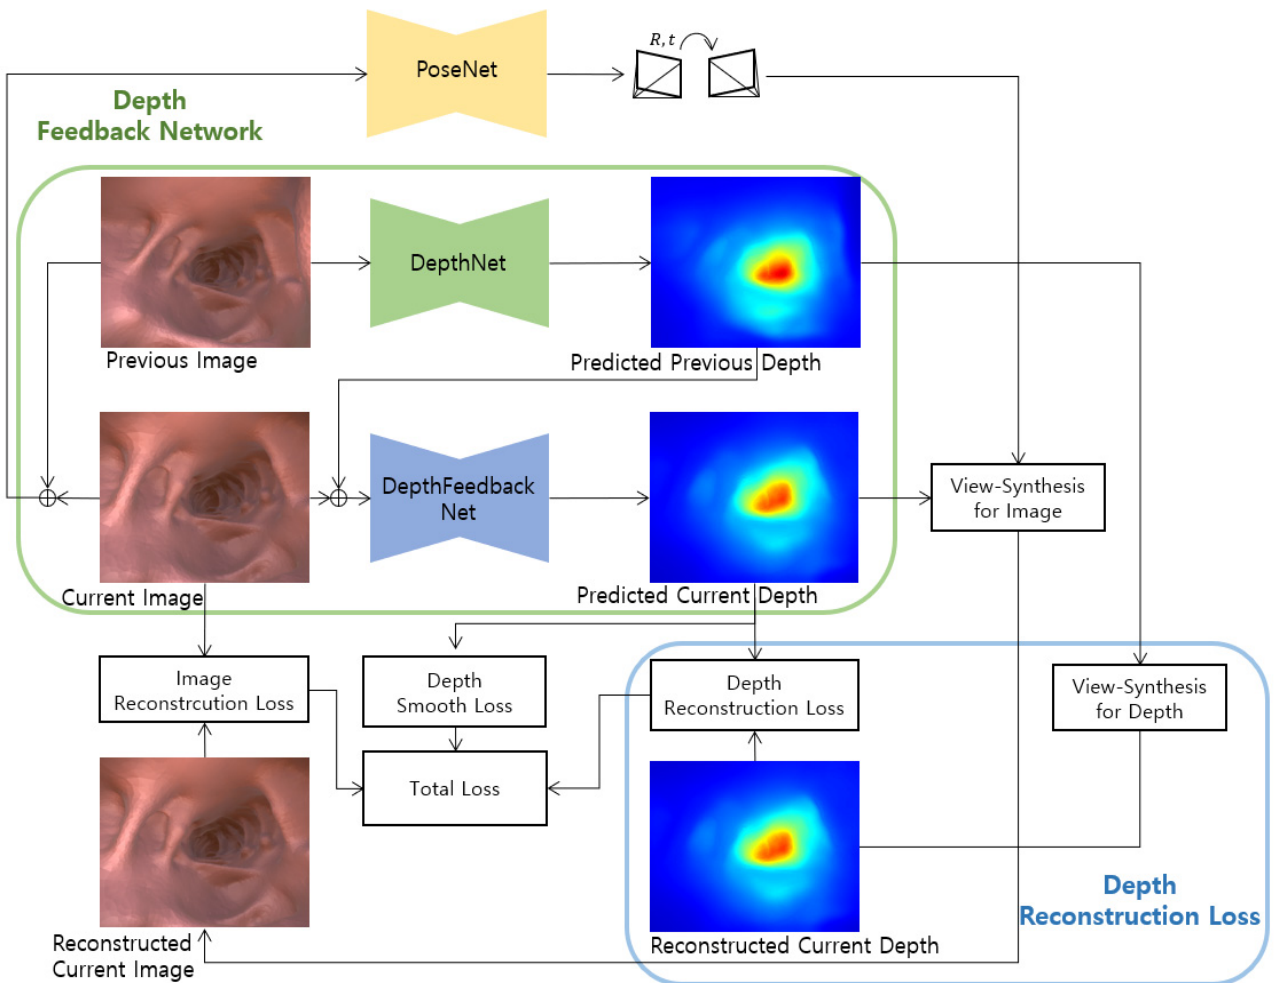
Figure 1. Our proposed self-supervised monocular network architecture. We introduce a depth feedback network and depth reconstruction loss.